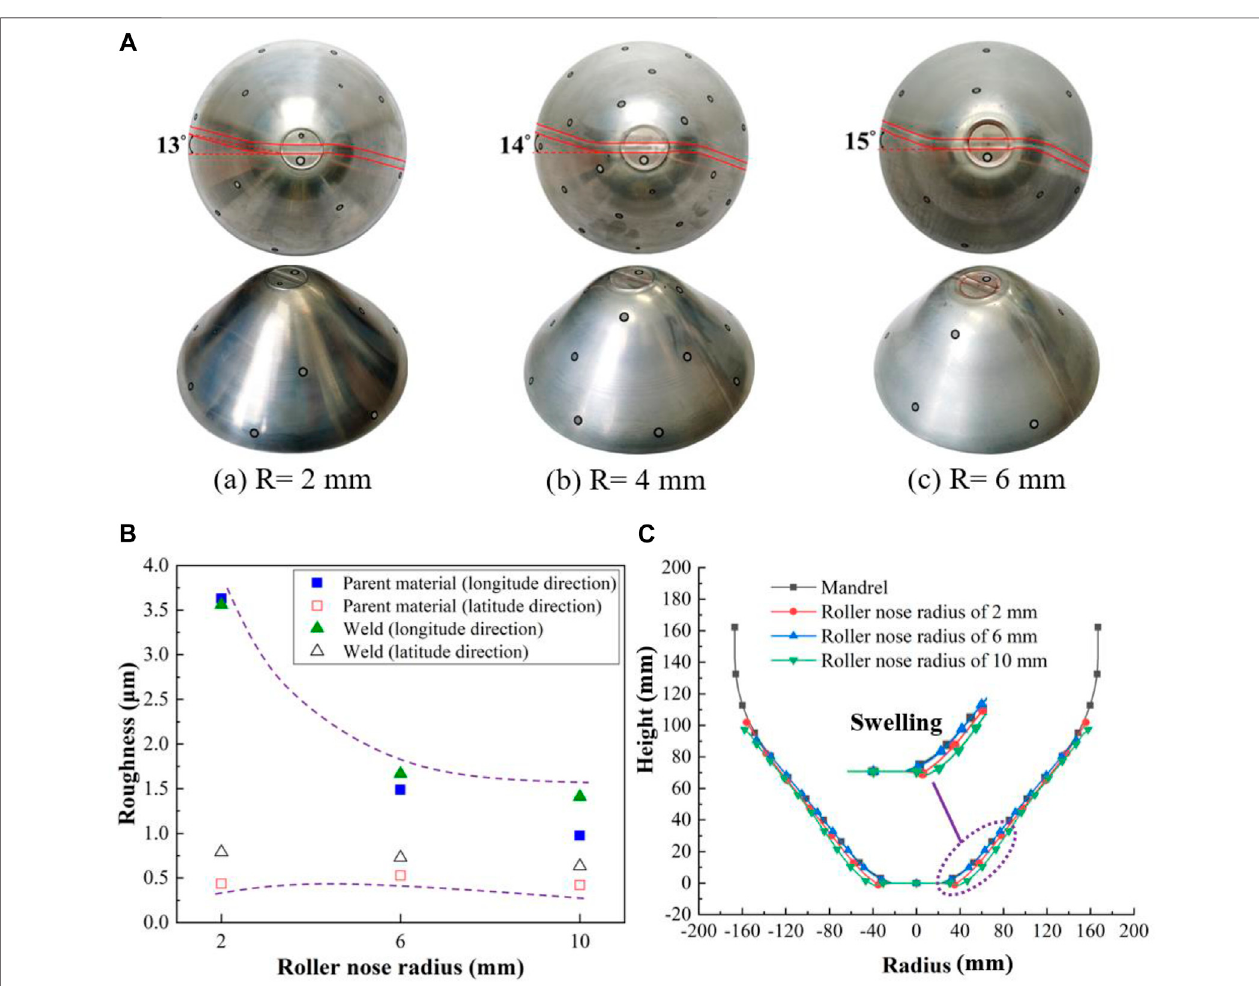
FIGURE4| Experimentalresults: (A) topandobliqueviewsofspunpartsundertherollernoseradiusof(a)R (cid:1) 2 mm,(b)R (cid:1) 6 mm,and(c)R (cid:1) 10 mm; (B) surface roughnesses of spun parts and (C) forming pro fi le of spun parts.